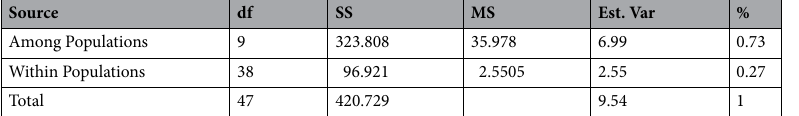
Table 5. Table representing analysis of molecular variance (AMOVA) among and within populations. Df = Degree of Freedom, SS = Sum of Squares, MS = Mean square, Est. Var. = Estimated Variance.